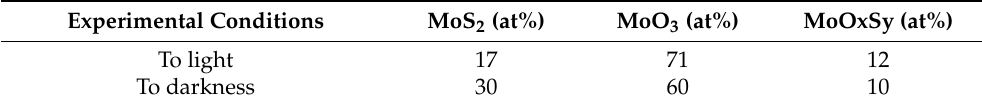
Table 2. Composition of the hybrid nanopowder after oxidation of MoS 2 by H 2 O 2 6% for 30 min, in function of light environment: to light or in the